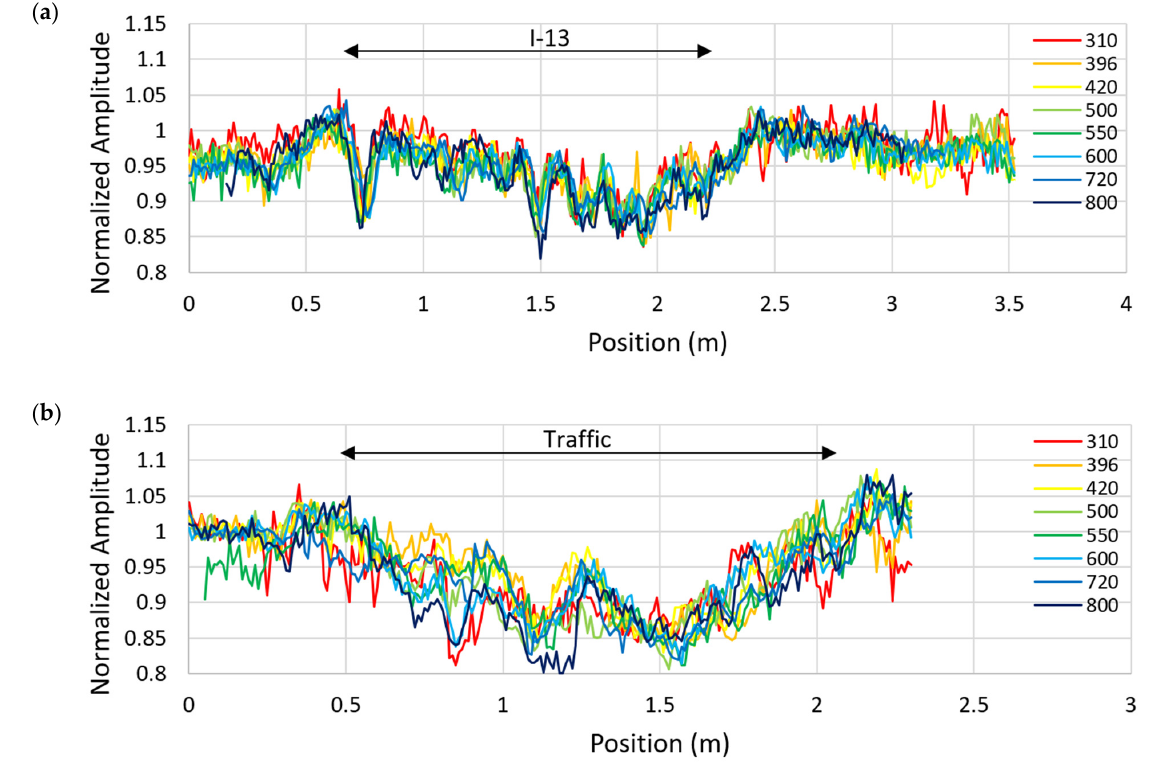
Figure A9. 1.5 GHz Norm. DW amplitudes on geotextile (I-12) in the ( a ) long. and ( b ) transv. direction vs. K loadings.